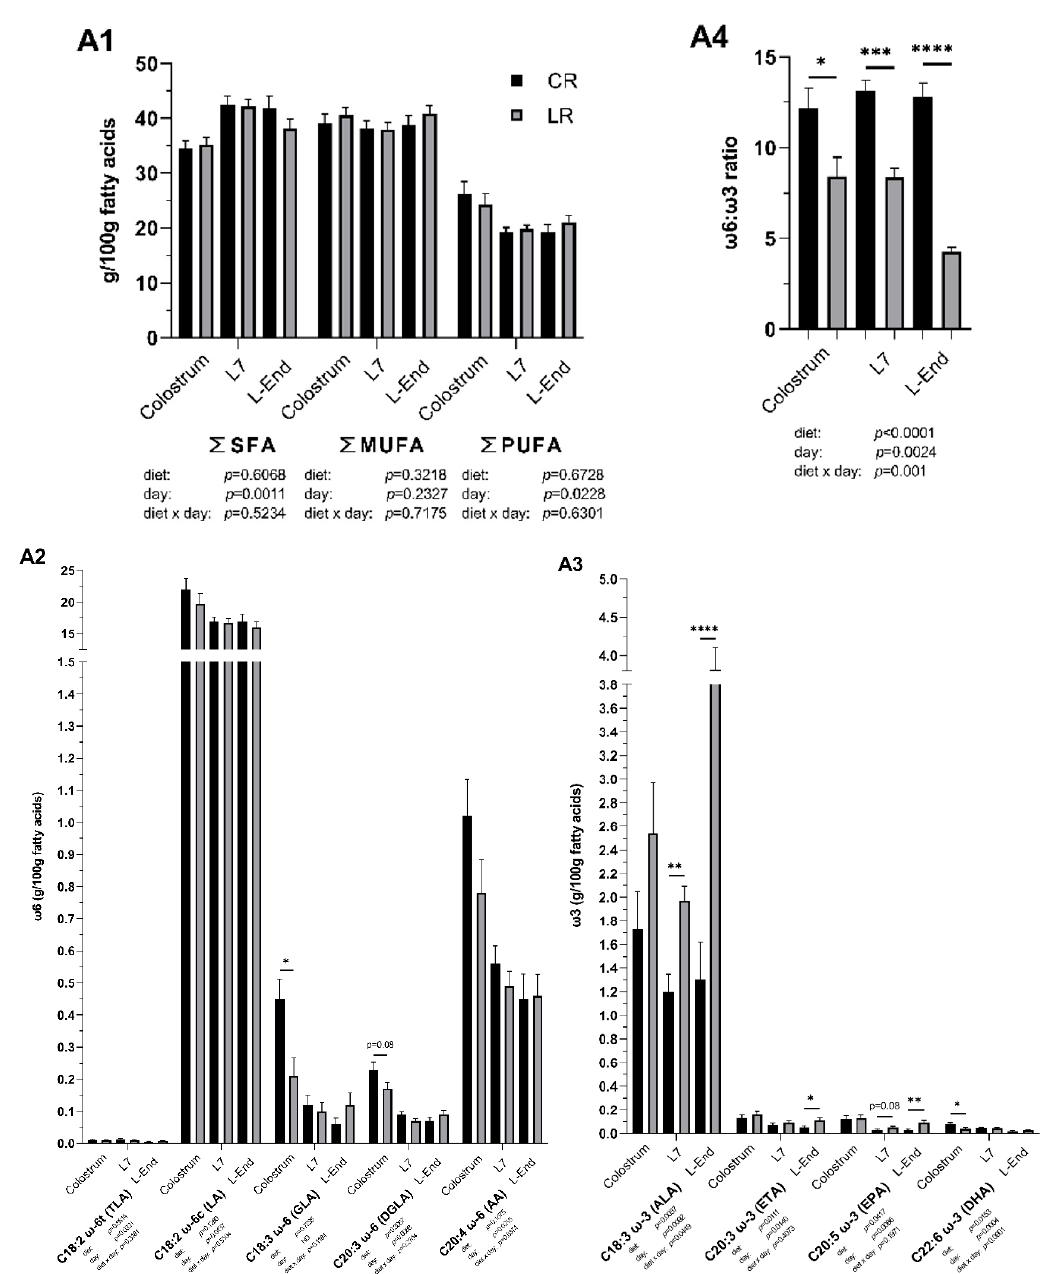
Figure 2. Fatty acid (FA) profile (g / 100 g FAs) of colostrum and milk collected on day 7 (L7) and the end of lactation (L-End) from sows fed diets included ω 6: ω 3 ratio = 13:1 during gestation, starting from day 28 (G28) and 10:1 during lactation (CR) or ω 6: ω 3 ratio = 4:1 from G28 until L-End (LR). A1 : SFA, MUFA and PUFA concentrations. A2 : Individual concentrations of ω 6 PUFAs. A3 : Individual concentrations of ω 3 PUFAs. A4 : ω 6: ω 3 ratio. SFA = Saturated FAs, MUFA = Monounsaturated FAs, PUFA = Polyunsaturated FAs, TLA = Linoleaidic acid, LA = Linoleic acid, GLA = γ -linolenic acid, DGLA = dihomo- γ -linolenic acid, AA = Arachidonic acid, ALA = α -linolenic acid, ETA = Eicosatrienoic acid, EPA = Eicosapentaenoic acid, DHA = Docosahexaenoic acid. Data are LSM ± SE; n = 5, 5 and 6 for CR group and 6, 7, 8 for LR group for colostrum, milk collected at L7 and L-End. * p < 0.05, ** p < 0.01, *** p < 0.001, **** p < 0.0001.